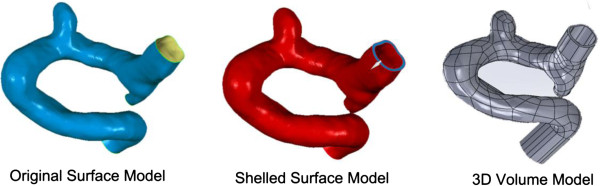
The reconstruction of original aneurysm model. The generations of original surface model, shelled surface model and 3D volume model are the main procedures in the reconstruction of aneurysm model based on a patient-specific aneurysm data.